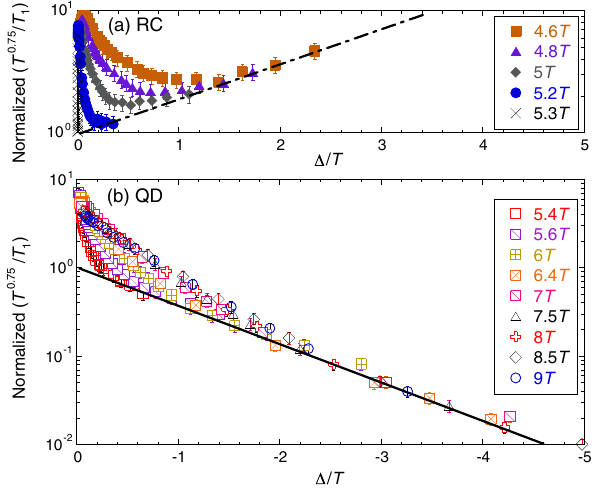
Fig. 8. The final results of Δ thus estimated from Fig. 8 are presented in Fig. 7(b) using filled triangle. We note that this procedure changes the estimated value of Δ only by a few K.